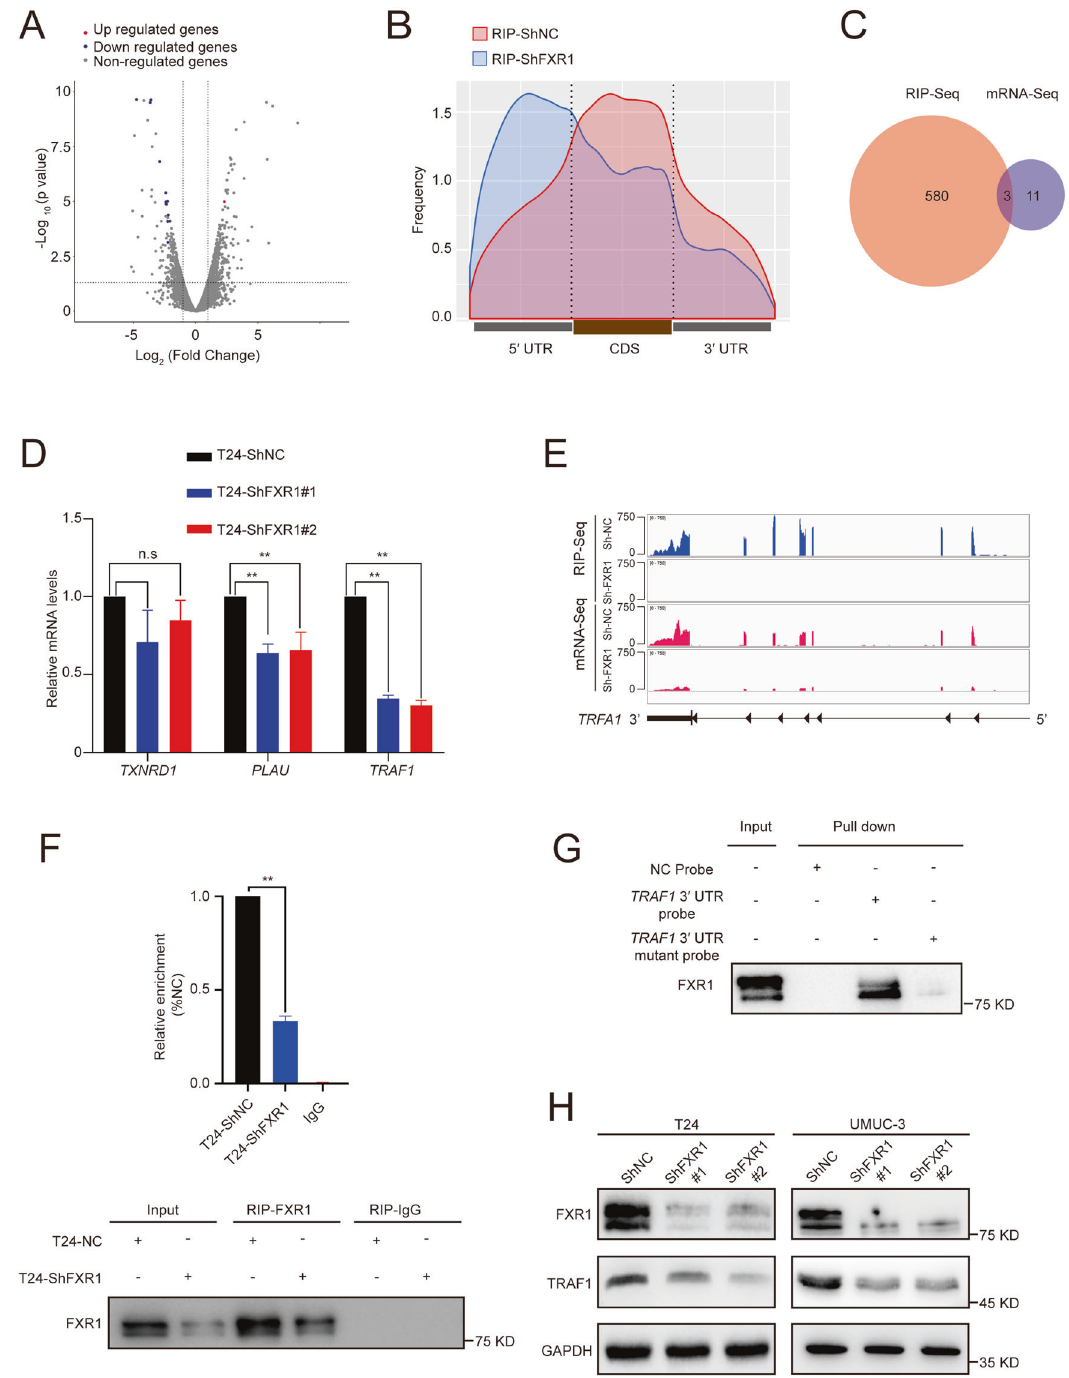
Fig. 4 FXR1 affects TRAF1 expression by regulating the 3 ′ UTR of TRAF1 mRNA. A Volcano plot showing the Log 2 fold change value in UCB cells transfected with control or FXR1 siRNA. Positive values on the x -axis indicate the Log 2 fold change of FXR1 siRNA versus control. The statistical signi fi cance ( − log 10 P ) is shown on the y-axis. Red dots and blue dots represent genes with signi fi cant upregulation or downregulation after FXR1 depletion, respectively. B Metagene pro fi les of FXR1 binding sites in control or FXR1 knockdown cells from RIP-seq. C The intersection of FXR1-binding target mRNAs and the decreased mRNA after FXR1 knockdown in T24 cells. D Extracts of control or FXR1 knockdown T24 cells were analyzed by RT-qPCR using PCR primers speci fi cally amplifying candidate transcripts. Data are presented as the mean ± SD, n = 3, ** p < 0.01 (Student ’ s t -test). E Integrative Genomics Viewer tracks displaying the FXR1 binding site on TRAF1 transcripts in control or FXR1-depleted T24 cells. F RIP and RT-qPCR analysis showed the enrichment of FXR1 on TRAF1 mRNA (upper panel). Western blot analysis showed the RIP ef fi ciency of the FXR1 antibody (bottom panel). Data are presented as the mean ± SD. ** p < 0.01 (Student ’ s t -test). G RNA pull-down assay showed the interaction between FXR1 and TRAF1 3 ′ UTR. H Western blot analysis revealed TRAF1 protein expression in control or FXR1 knockdown